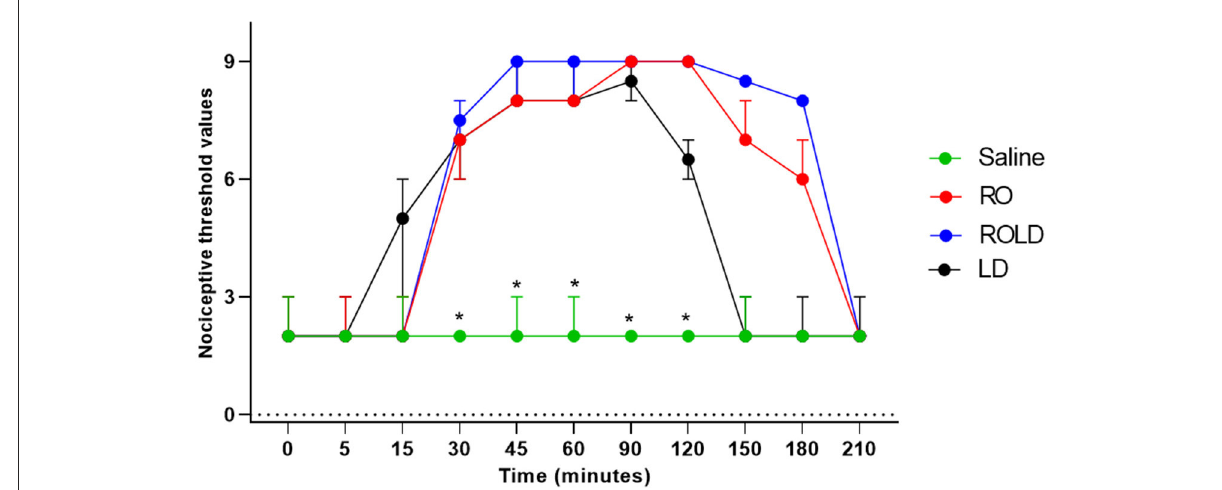
FIGURE4 Nociceptive threshold values (median and range) in the perineum pre- epidural and post- epidural administration of saline ( n = 6), romifidine (RO) (50 µ g kg − 1) ( n = 6), romifidine-lidocaine (ROLD) (50 µ g and 0.30mg kg − 1) ( n = 6) and lidocaine (LD) (0.3 0m kg − 1) ( n = 6) in donkeys. *: Saline differ significantly from RO, LD, and ROLD combination.